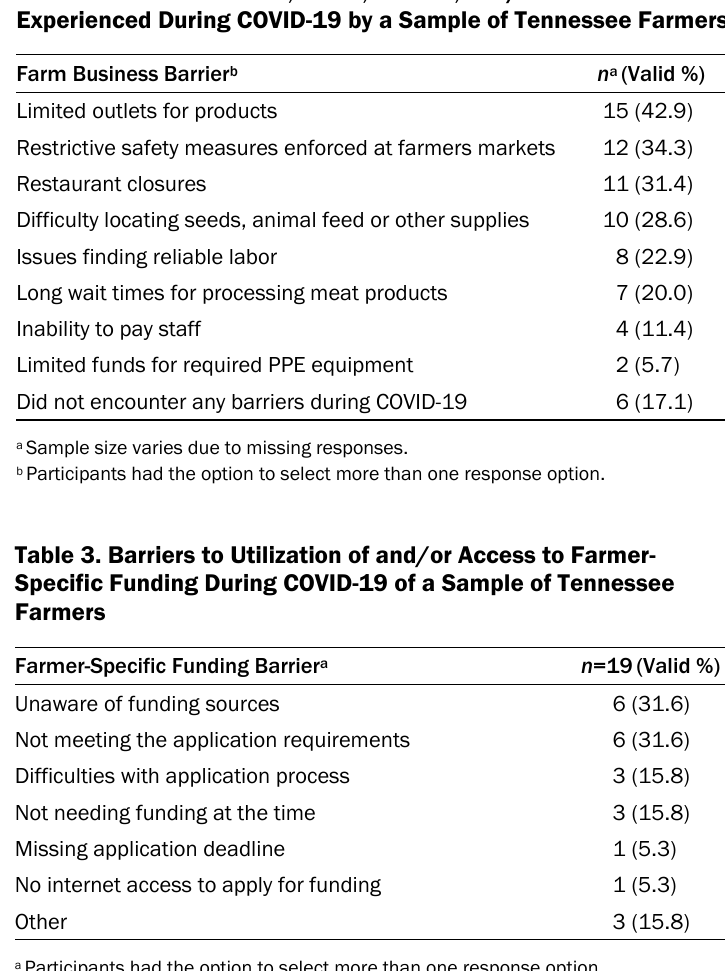
Table 2. Barriers to Grow, Raise, Market, and/or Sell Products